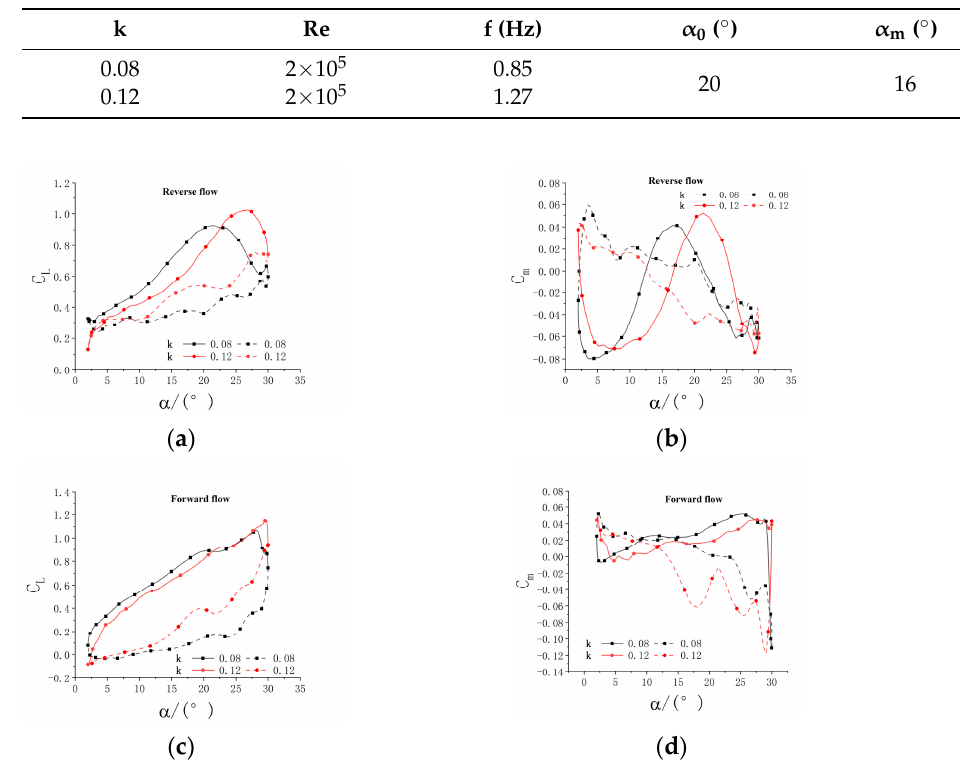
L , ( b ) C m , ( c ) C L , ( d ) C m